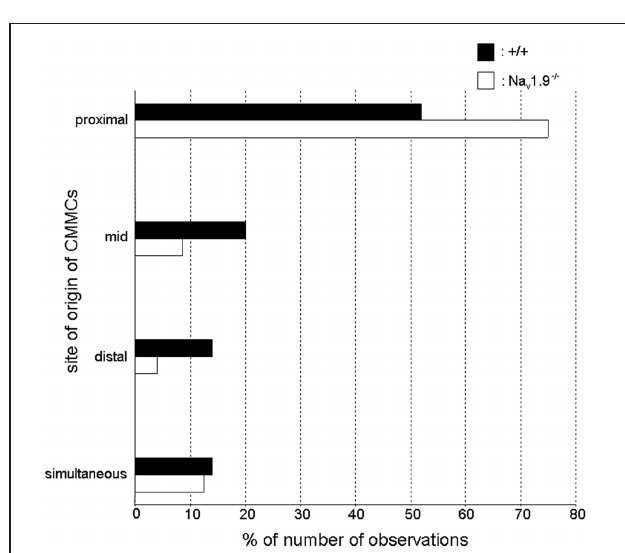
FIGURE 6 | Graphic representation of the site of origin of CMMCs in wild-type and Na v 1.9 − / − mice. In + / + mice, about 50% of CMMCs propagated from the proximal region. This proportion increased to 75% in Na v 1.9 − / − mice. The site of origin of CMMCs was significantly different in the colon of Na v 1.9 − / − mice compared to that of + / + mice ( P < 0 . 05).